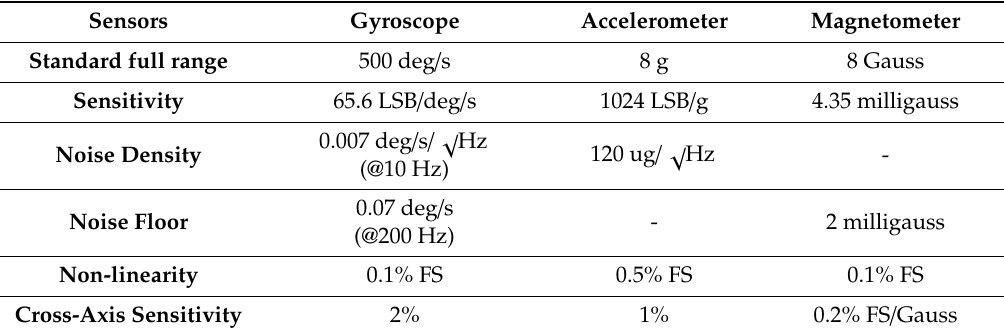
Figure 8. VT-IMUs wearable devices and installation. Table 2. The performance parameters of the